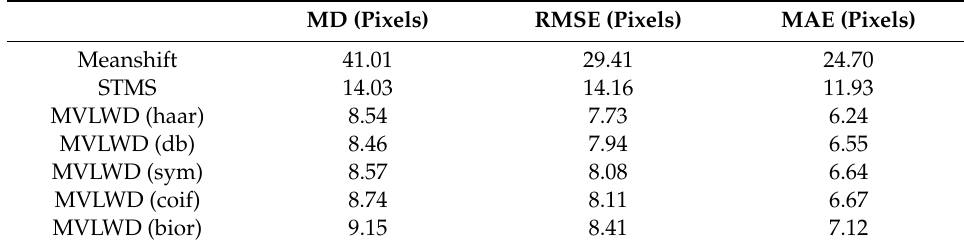
Table 1. Statistical performances for the three trackers on video